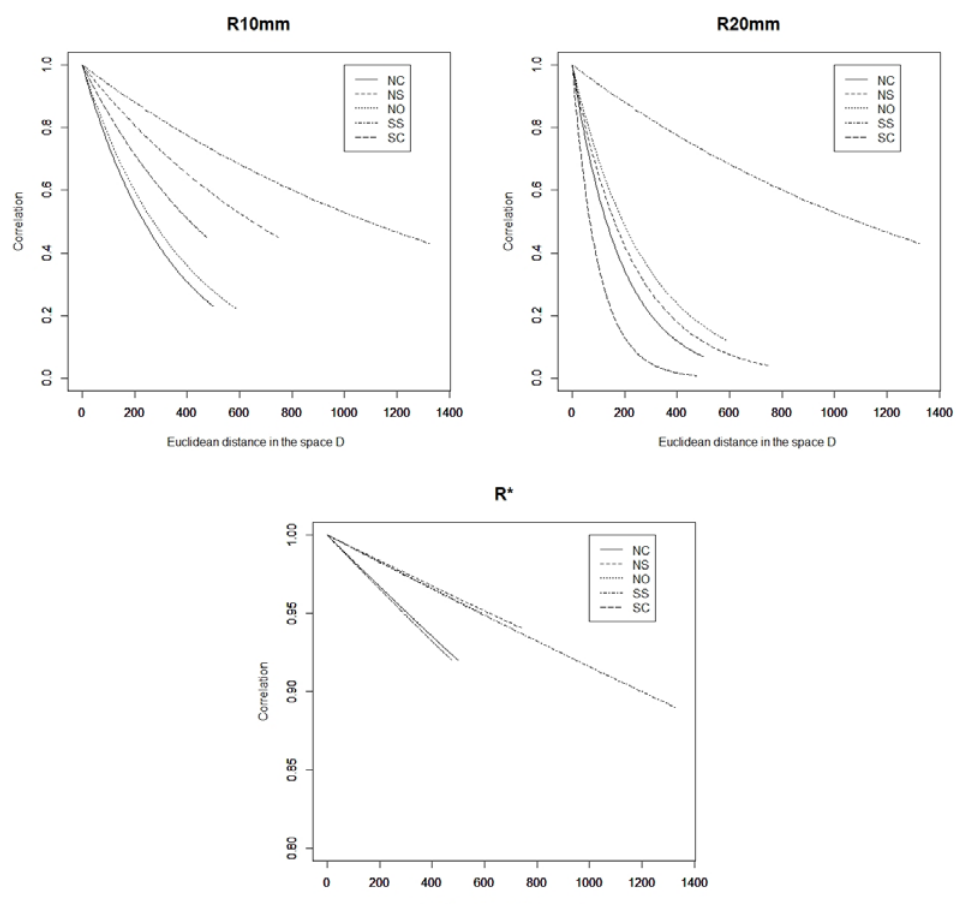
Figure 4. Correlation function estimated for each index and region. Scale of Euclidean distances measured in kilometers.